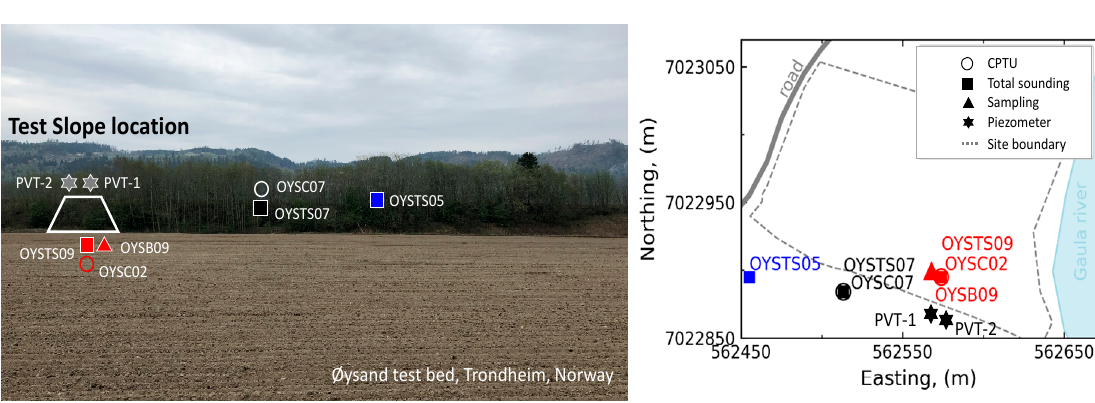
Figure 2. Location of test slope and field tests at Øysand site.